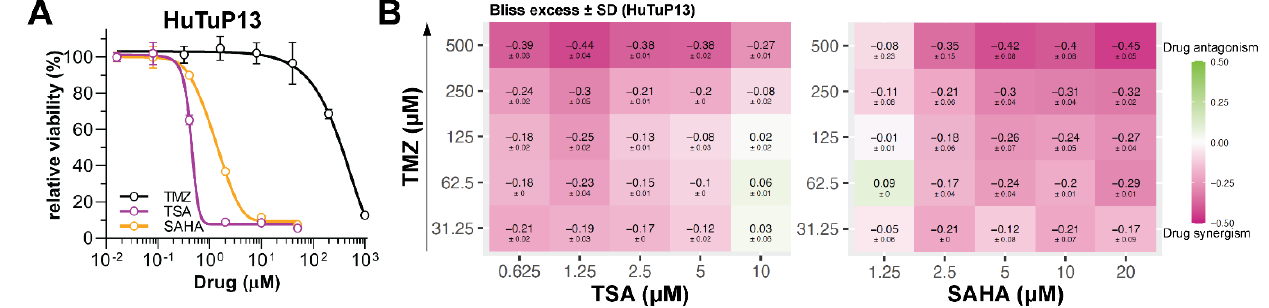
Figure 2. HDI affect GBM cell viability/proliferation and synergy with TMZ. ( A ) Dose-response viability curves of HuTuP13 GBM cells exposed to scalar doses of TSA, SAHA, or TMZ for 72 h. ( B ) Heatmaps displaying Bliss excess value matrixes of TSA (left) and SAHA (right) response in GBM cells (HuTuP13) when combined with TMZ. SD: standard deviation.